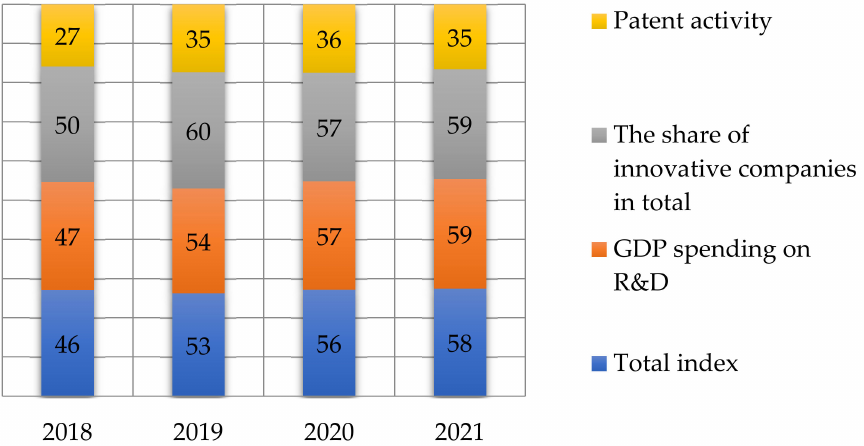
Figure 4. Ukraine’s place in the Bloomberg Innovation Index in 2018–2021. Adapted with permission from [39]. Copyright 2021, European